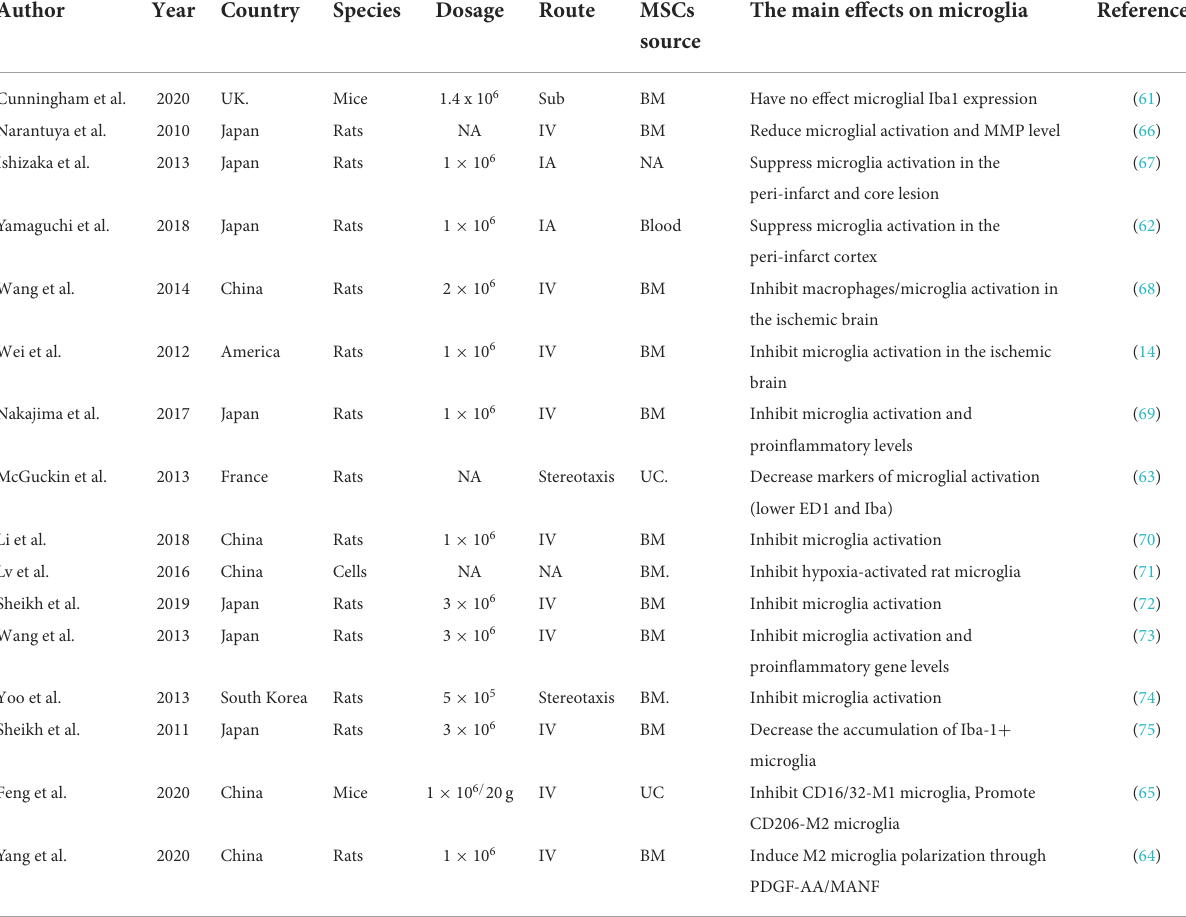
TABLE 1 Preclinical stroke studies assessing the effect of MSCs on the activation of microglia.